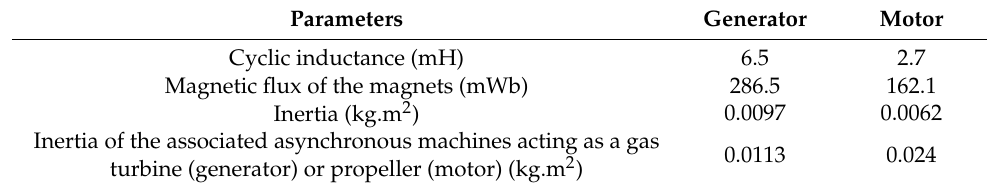
Table 1. Original parameters of the system.